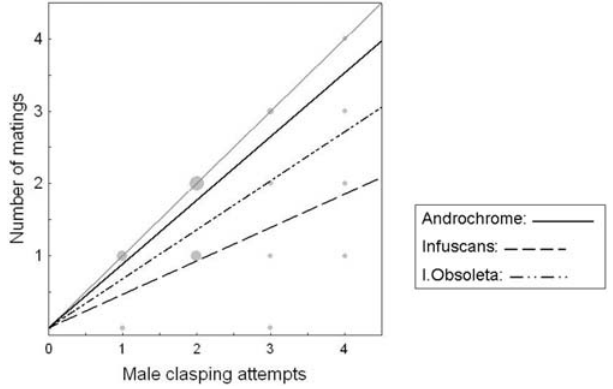
Figure 3. Morph-specific variation in female resistance to male mating attempts. Relationships between the number of matings (Y- axis) and the number of male clasping attempts received by each morph (X-axis). The fine dotted line marks a (hypothetical) 1:1 slope, where every clasping attempt by a male ends in a mating. Regression lines below the 1:1 relationship reveals morph-specific levels of female resistance towards mating attempts from males. The regression slopes differ significantly between the three female morphs (Morph * No. Male Claspings: F 2,266 =5.373, P=0.005). Differences between androchrome females (solid regression line) and infuscans-females (dashed line) remains significant even if the morph with the lowest sample size (Infuscans obsoleta (dash-dot line)), is excluded from the data-set (F 1,260 =10.072, P=0.002). Regression slopes of both androchrome females and infuscans-females differ significantly from unity (upper 95 % CL: 0.987 and 0.697 respectively), showing that both morphs do not accept all male mating attempts and show some degree of resistance. Sizes of the data points are proportional to the sample size at each position (range: 1–97